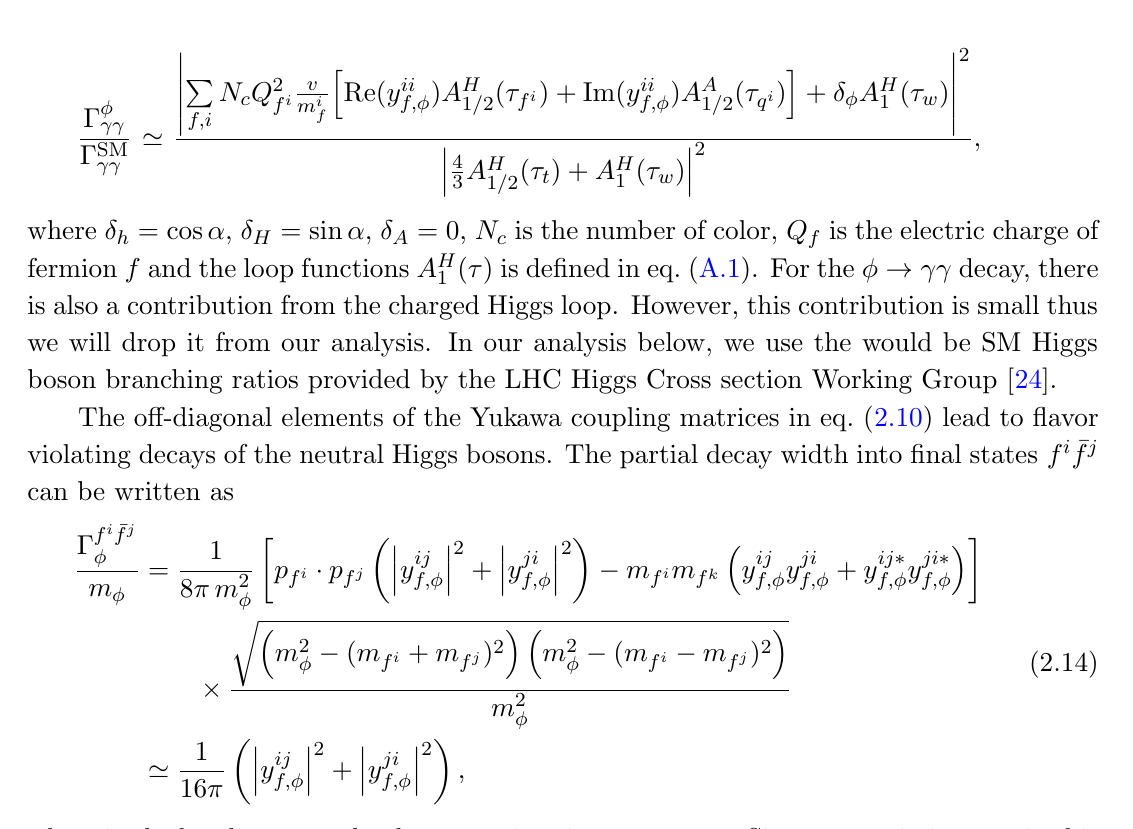
(cid:28)(cid:22) channel is shown in blue, t (cid:22) t channel in orange, hZ ! = 0 : 1 while on the right pane U